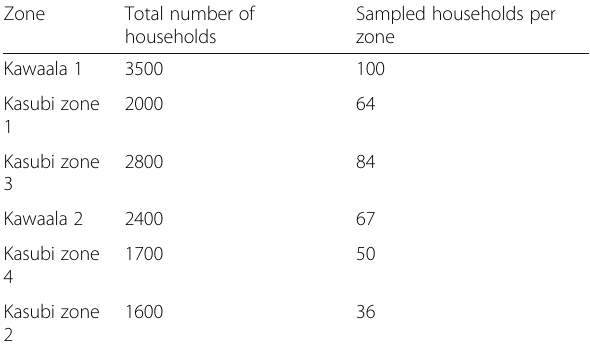
Table 1 Sample size distribution across the zones